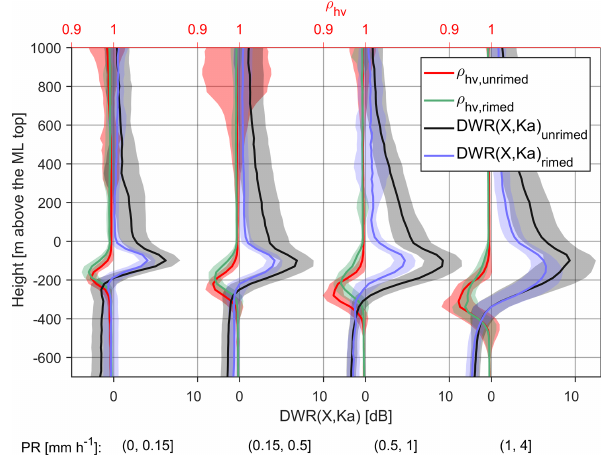
Figure 6. Same as Fig. 5 but for DWR(X, Ka). Note that the radar calibration is made by matching the X- and Ka-band radar reflectiv- ities at precipitation